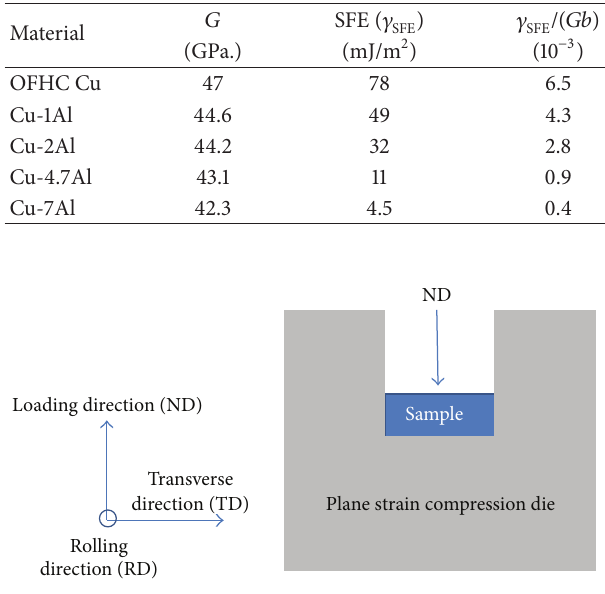
Figure 1: Schematic drawing of the plane strain compression